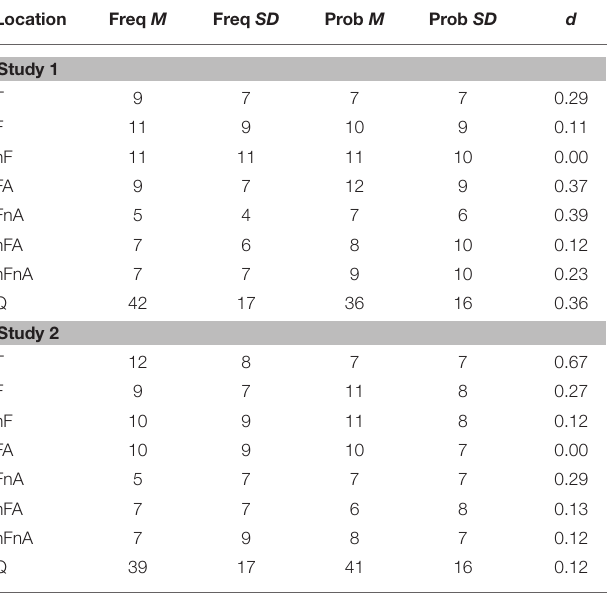
TABLE 3 | Means ( M ) and standard deviations ( SD ), for Dwell Time in percentages for each location, for the frequency format (left) and probability format (right), and for study 1 (top) and study 2 (bottom).